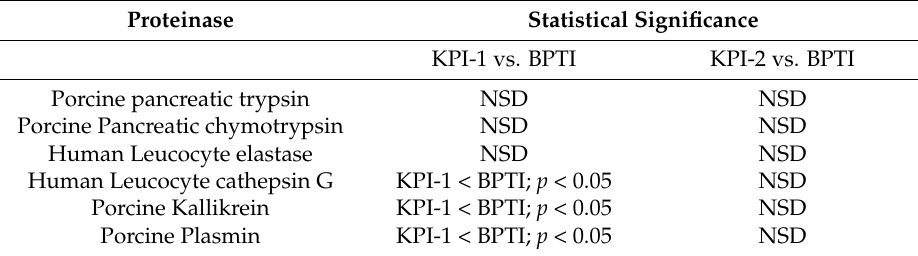
Table 2. Serine proteinase inhibitory activities of the Bikunin Kunitz KPI domains and